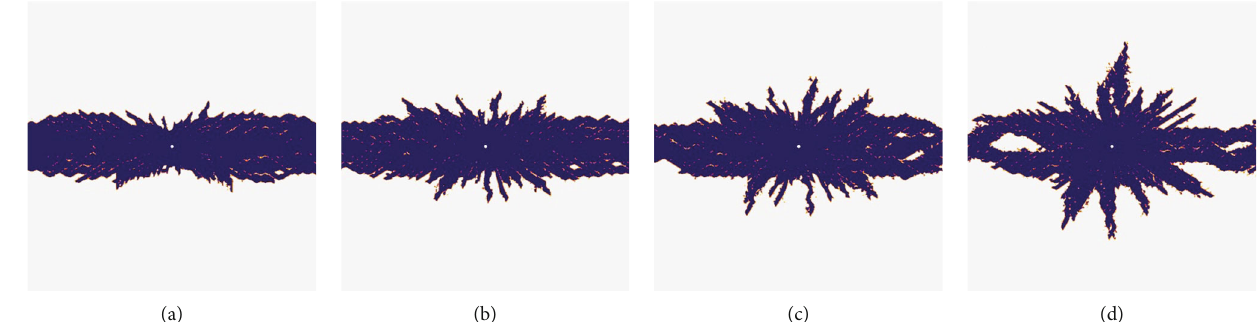
Figure 9: Distribution of damaged area under di ff erent anisotropy coe ffi cients at 120min. (a) λ = 0 : 1, (b) λ = 0 : 2 , (c) λ = 0 : 3 , and (d) λ = 0 : 5 .